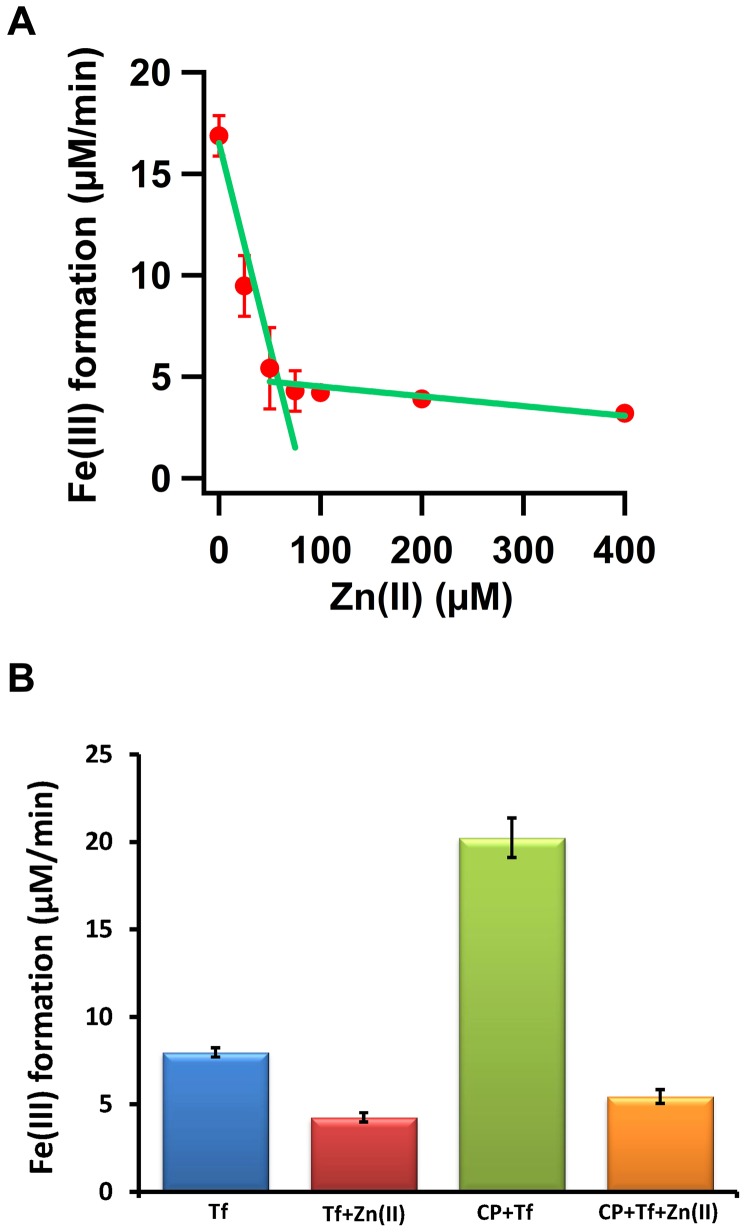
Inhibitory effect of Zn(II) on diferric-transferrin complex formation.(A) Initial rates of diferric-transferrin formation at 460 nm are plotted versus concentration of Zn(II). Concentration of apo-transferrin was 80 µM and that of Fe(II) was 200 µM. (B) Comparison of the inhibitory effect of Zn(II) on the diferric-transferrin complex formation for the non-enzymatic oxidation of Fe(II) by molecular oxygen in the presence of transferrin (Tf 70 µM) and for the ferroxidase activity of ceruloplasmin (CP 0.08 µM) measured with the transferrin assay. Final concentration of Fe(II) was 60 µM and that of Zn(II) was 70 µM. Measurements were done in 100 mM Hepes buffer, 100 mM NaCl, pH 7.2 in triplicate at 37°C.